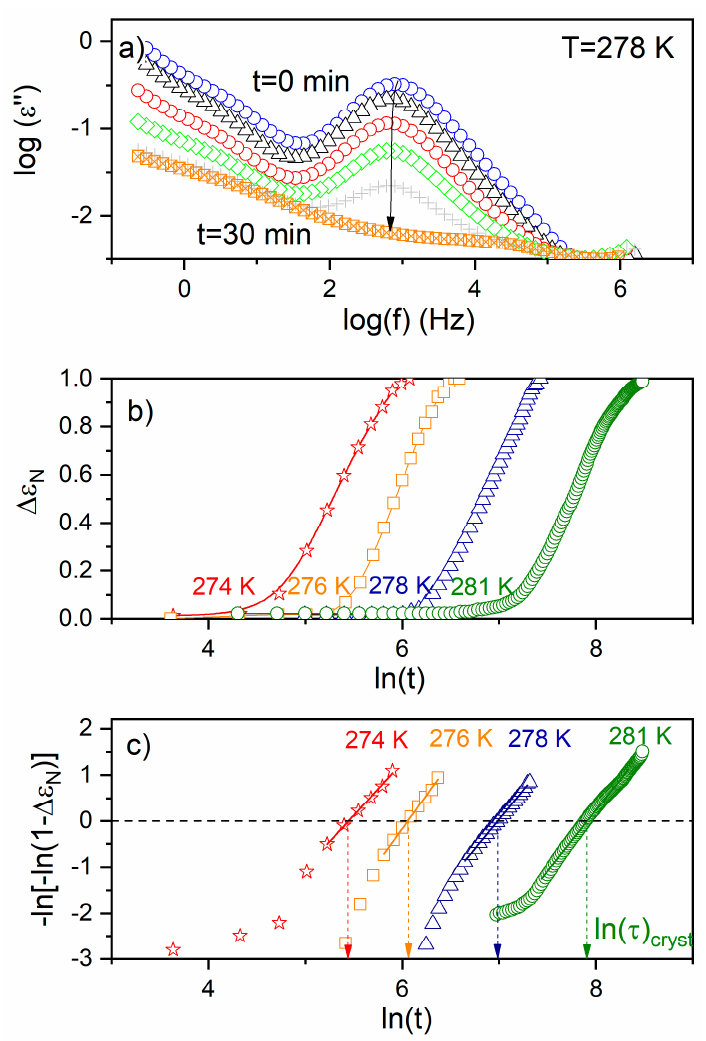
Figure 7. ( a ) The imaginary parts of the complex dielectric functions obtained upon isothermal crystallization of BBOA at 278 K. The arrow indicates the direction of changes in the loss spectra during the crystallization process. ( b ) Time evolution of the normalized dielectric strength ( ∆ ε N ) during isothermal crystallization of BBOA at 274 K, 276 K, 278 K and 276 K. ( c ) Avrami plot of ∆ ε N (t) for the data presented in the panel ( b ).